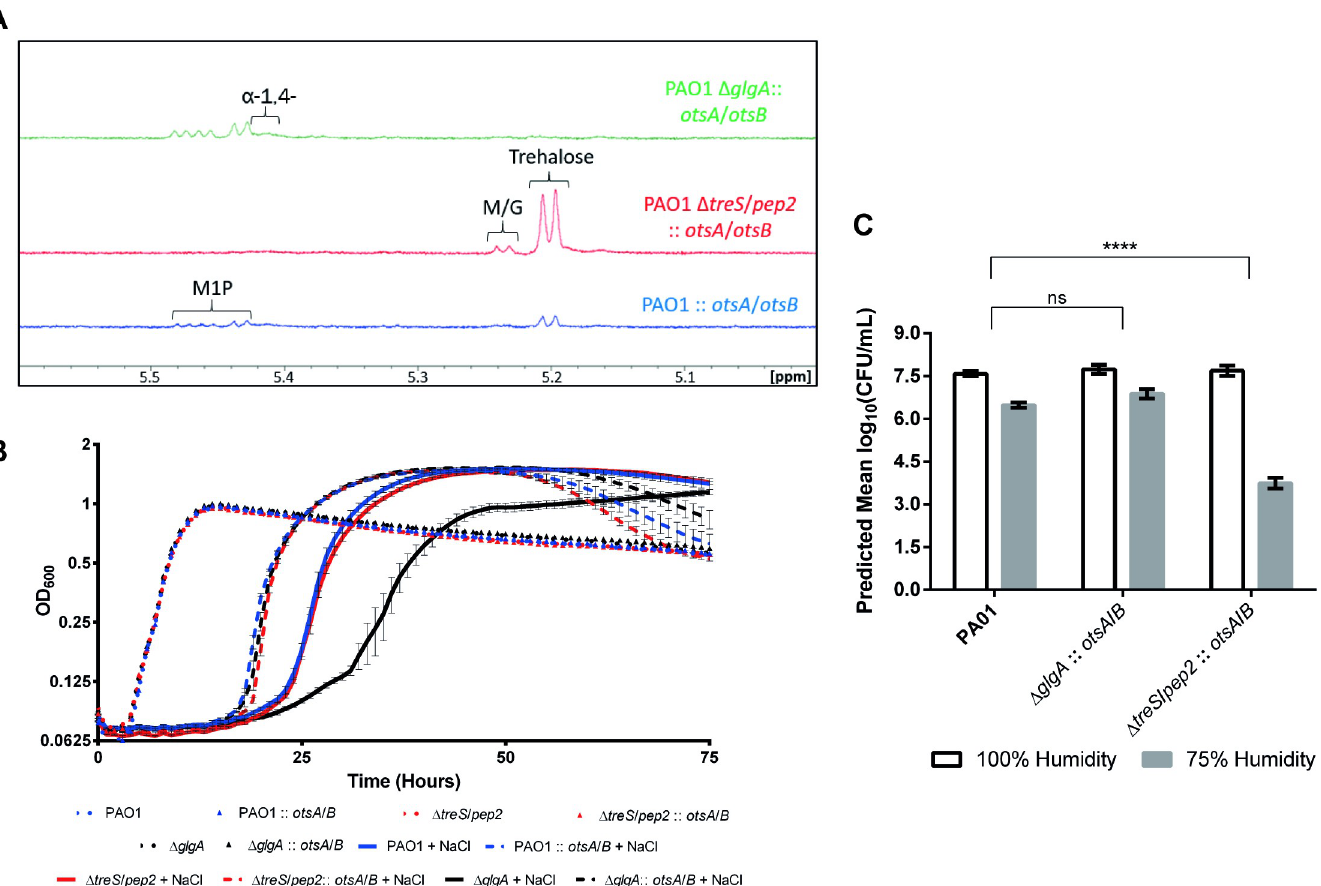
Fig 10. A) 1 H-NMR spectra for PAO1 strains expressing otsA/B . Peaks corresponding to key metabolites are indicated. M/G–maltose/glucose, α -1,4-– α -glucan. B) Growth curves of PAO1 strains expressing otsA/B subject to osmotic stress conditions. OD 600 is plotted against time for strains grown in the presence (+ NaCl, solid lines) and absence (dotted lines) of 0.85 M NaCl. Data are shown +/- standard error of 3 technical replicates. At least two independent biological replicates were conducted per strain and a representative curve is shown in each case. C) Survival of PAO1 strains expressing otsA/B subjected to desiccation stress conditions. Graphs show predicted mean log(CFU/ml) for strains grown in 100% (white bars) or 75% (grey bars) relative humidity. The response to desiccation is the difference log (CFU/ml) at 100% and 75% RH. P-values for differences between strains’ responses were calculated by linear mixed modelling to account for the multiple levels of random variation in biological and technical replicates and are shown with asterisks (ns: p > 0.05 [not significant], ���� : p < 0.0001). Responses were tested in at least two independent biological replicates on different